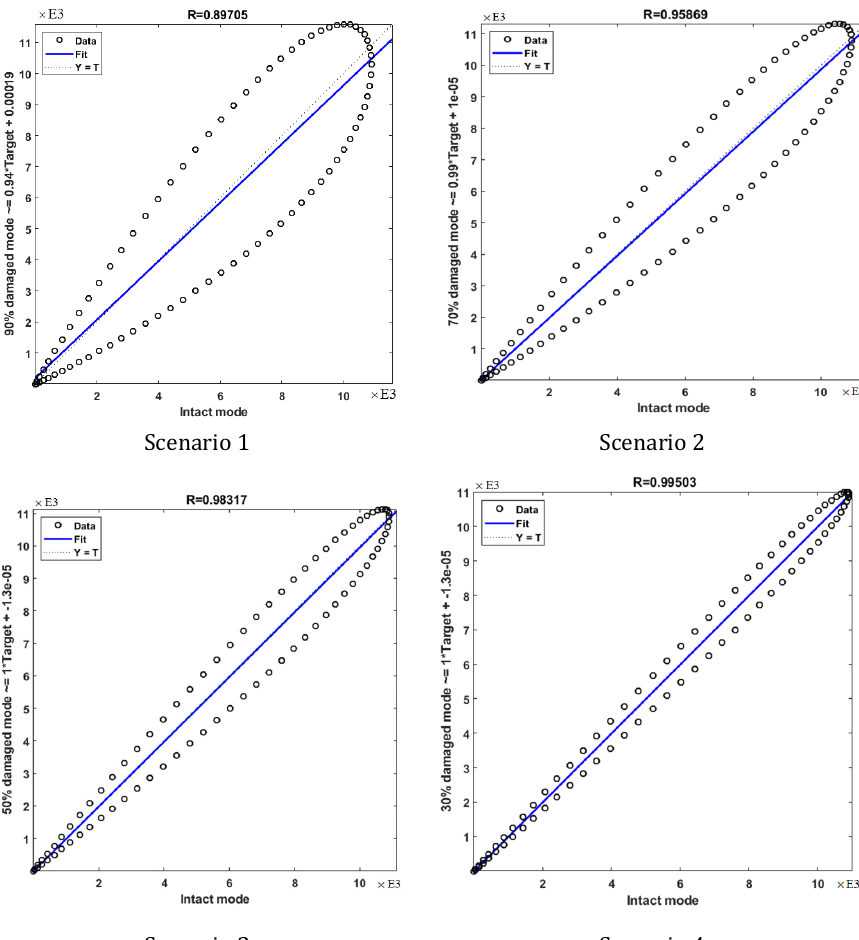
Figure 6. Regression diagram for the four considered scenarios.